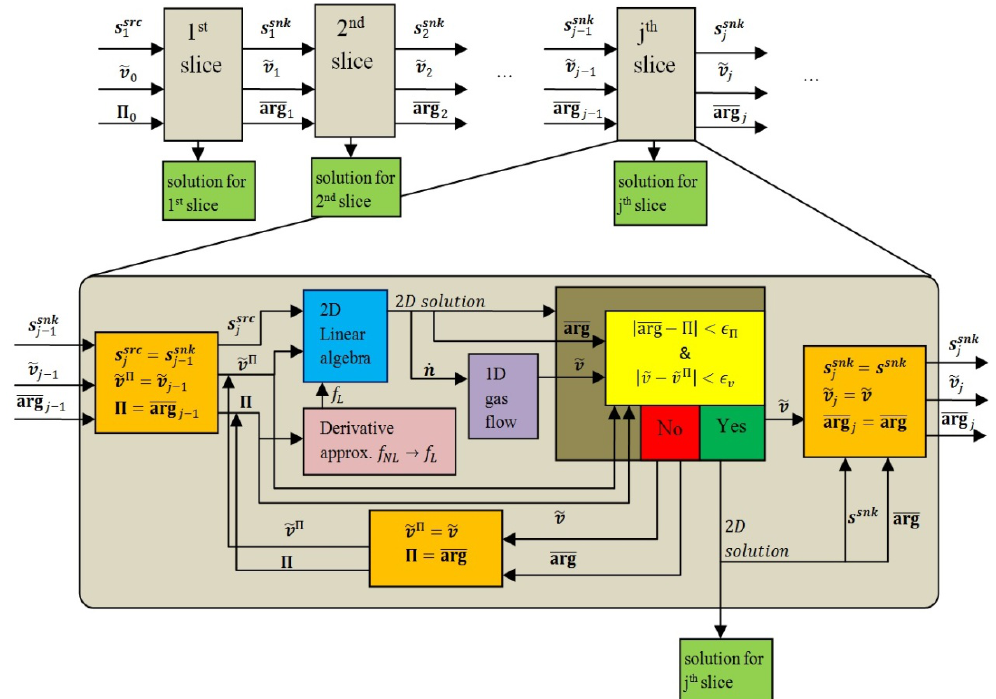
Figure 4. Calculation procedure for obtaining the solution for the whole fuel cell as a sequence of solutions for individual slices. Symbols in bold denote sets of variables of the same type i.e. , (cid:1871) (cid:3046)(cid:3041)(cid:3038) = {(cid:1871) (cid:3002)(cid:3015)(cid:3005)(cid:3046)(cid:3041)(cid:3038) , (cid:1871) (cid:3004)(cid:3021)(cid:3009)(cid:3046)(cid:3041)(cid:3038) } , (cid:1874)(cid:3556) = {(cid:1874)(cid:3556) , (cid:1874)(cid:3556) } , (cid:1866)(cid:4662) = {(cid:1866)(cid:4662) , (cid:1866)(cid:4662) } , (cid:3002)(cid:3015)(cid:3005) (cid:3004)(cid:3021)(cid:3009) (cid:3002)(cid:3015)(cid:3005) (cid:3004)(cid:3021)(cid:3009) arg(cid:3364)(cid:3364)(cid:3364)(cid:3364) = {arg(cid:3364)(cid:3364)(cid:3364)(cid:3364) , arg(cid:3364)(cid:3364)(cid:3364)(cid:3364) } , Π = {Π , Π } ; (cid:1874)(cid:3556) (cid:2952) is the predictor value for mean (cid:1878) -component (cid:2869) (cid:2870) (cid:2869) (cid:2870) velocity. The blue box represents solving the set of linear algebraic equations described in Subsection A.4 of Appendix A, the pink box represents the derivative approximation of all nonlinear functions according to (general) Equation (83) or (specific) Equations (A71), (A75) and (A76) in Appendix A. Purple box represents calculating the 1D gas-flow Equations (85) and